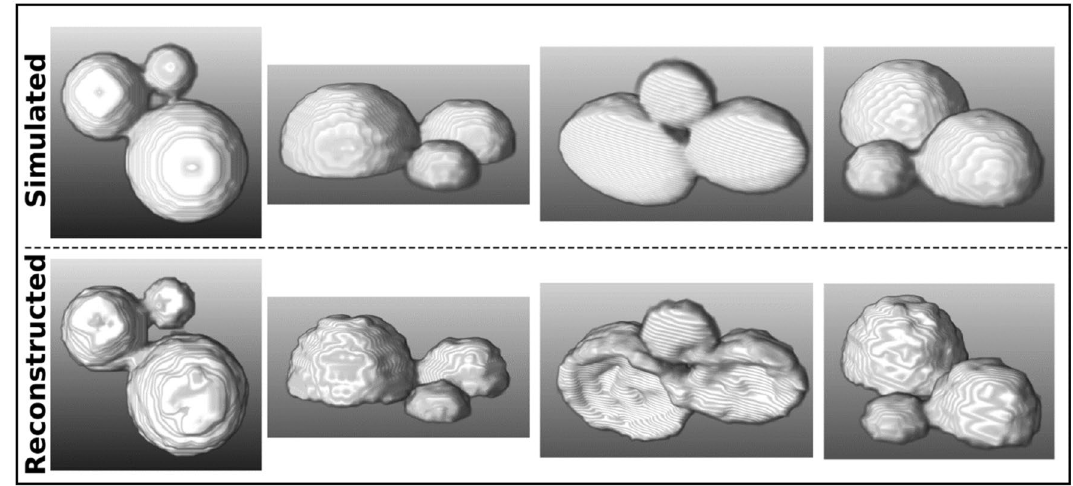
Figure 4. Comparison of simulated sample (top row) versus the reconstructed sample (bottom row).